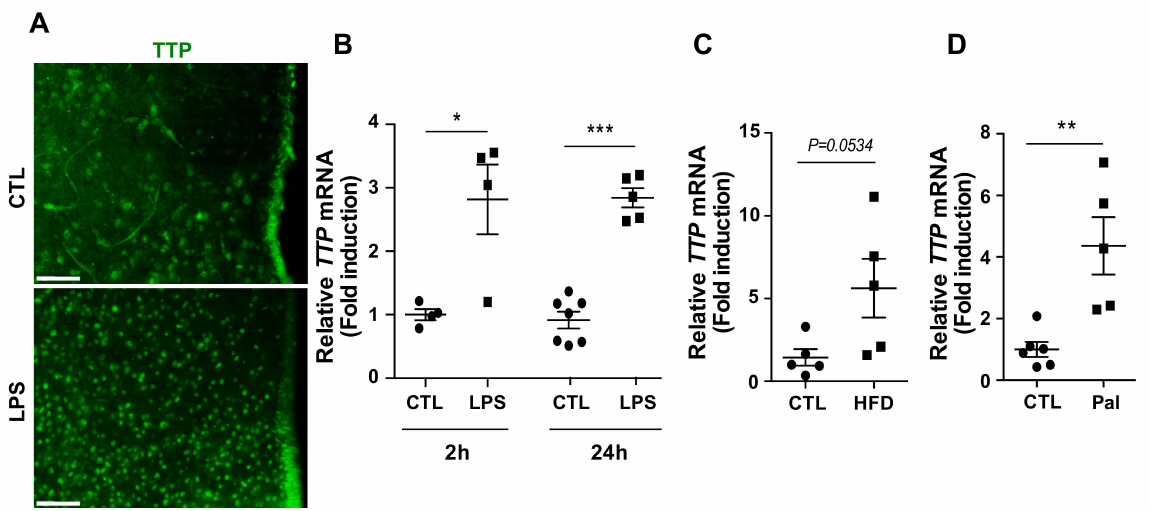
Figure 1. Elevation of Tristetraporlin (TTP) protein and mRNA expression levels by multiple inflammatory stimuli. ( A ) Representative image showing increased signals of TTP protein in the hypothalamus upon lipopolysaccharide (LPS) intraperitoneal (i.p.) injection into C57BL/6 mice as determined by immunohistochemistry. qPCR data show elevated TTP mRNA in response to inflammatory stimulants including ( B ) lipopolysaccharide (LPS, treated for 2 h or 24 h), ( C ) HFD (high-fat diet), and ( D ) Palmitic acid (Pal). Data are presented as the mean ± SEM. n = 4–6 mice per group for LPS treatment; n = 5 mice per group for HFD treatment; n = 5–6 mice per group for palmitic acid treatment. * p < 0.05, ** p < 0.01, and *** p < 0.001. Scale bar = 100 µ m. SEM; standard error of the